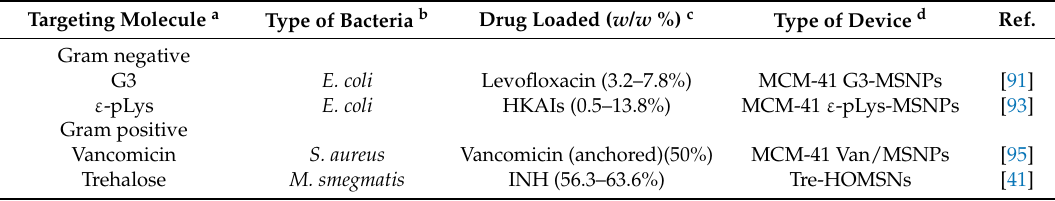
Table 2. Targeted Mesoporous Silica Nanoparticles for the Treatment of Planktonic